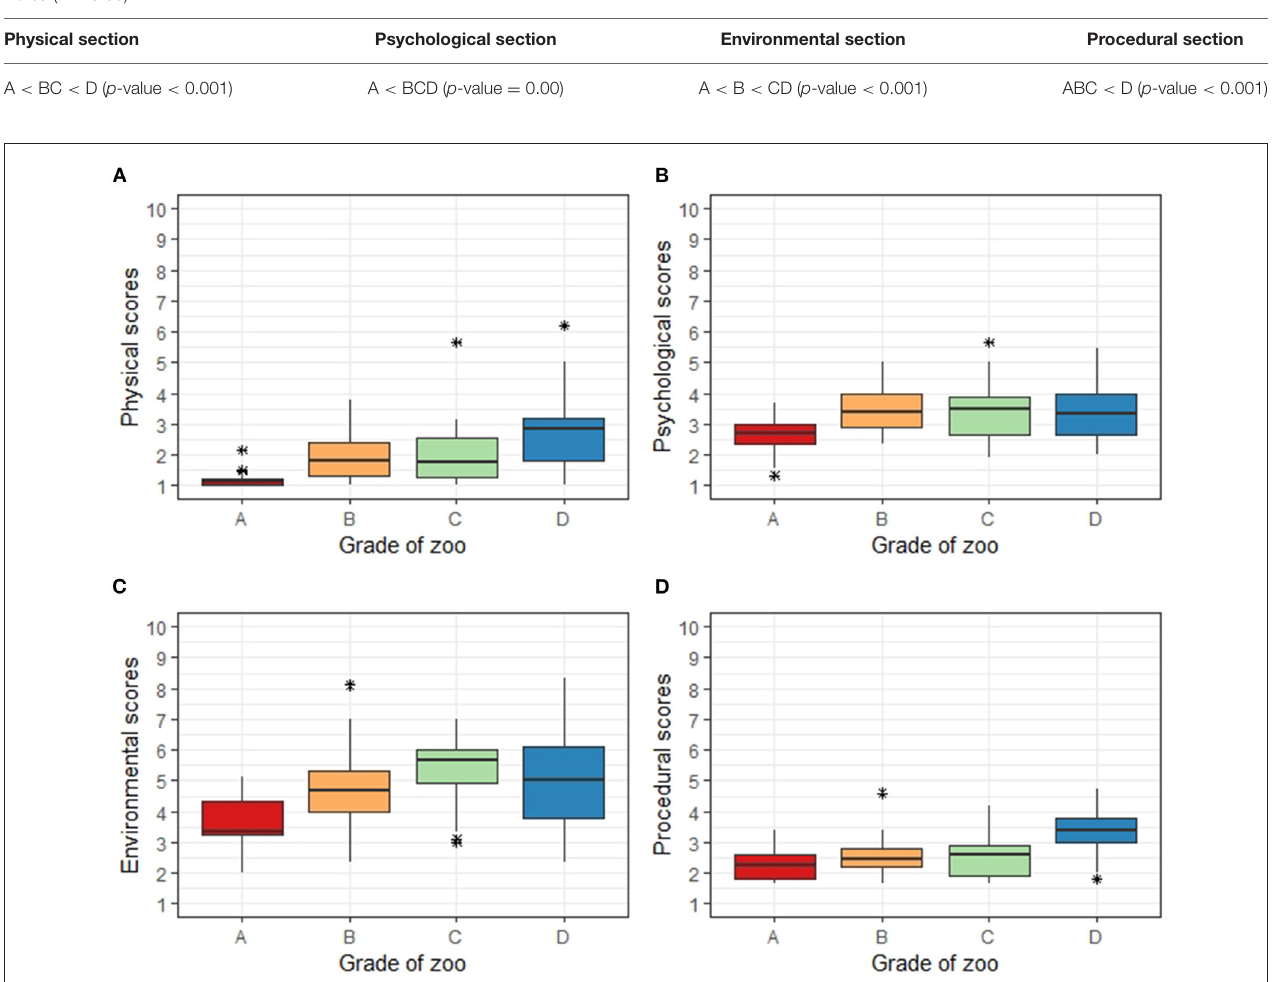
TABLE 5 | Results of Kruskal–Wallis Analysis of variance (ANOVA) about the statistical difference of four AWAG section by the four level of zoos (A, B, C & D) in South Korea ( α = 0.05).